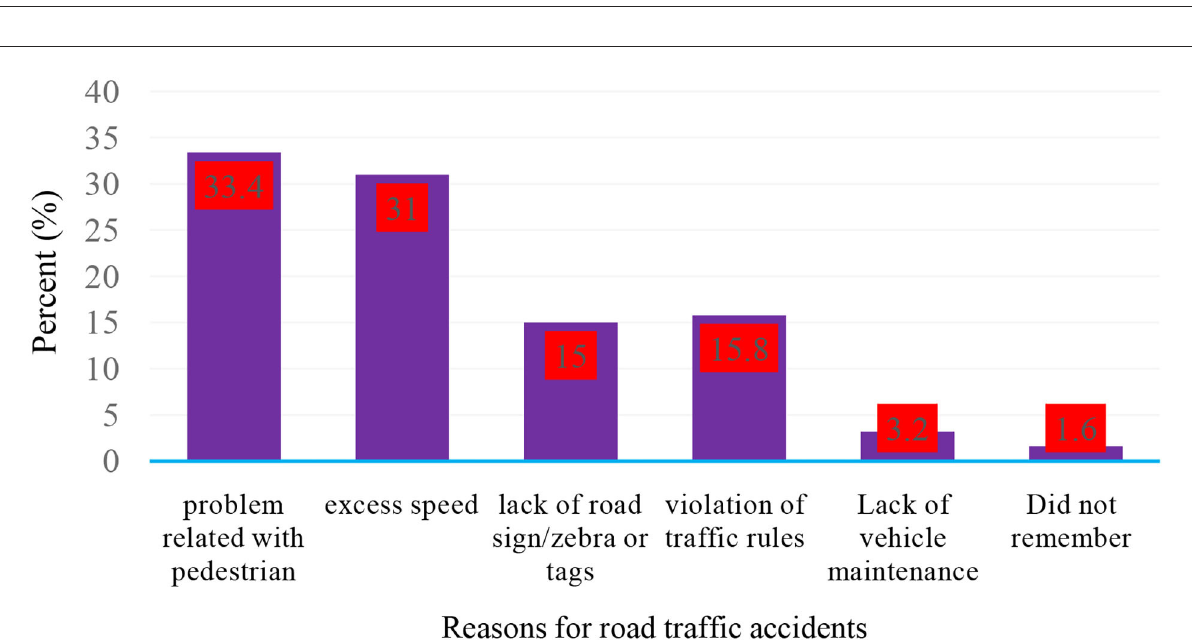
FIGURE3 Reasons for road traffic accidents among participants who have had road traffic accidents in the past year in Dilla Town, Gedeo Zone, Southern Ethiopia, 2021 (n = 316).